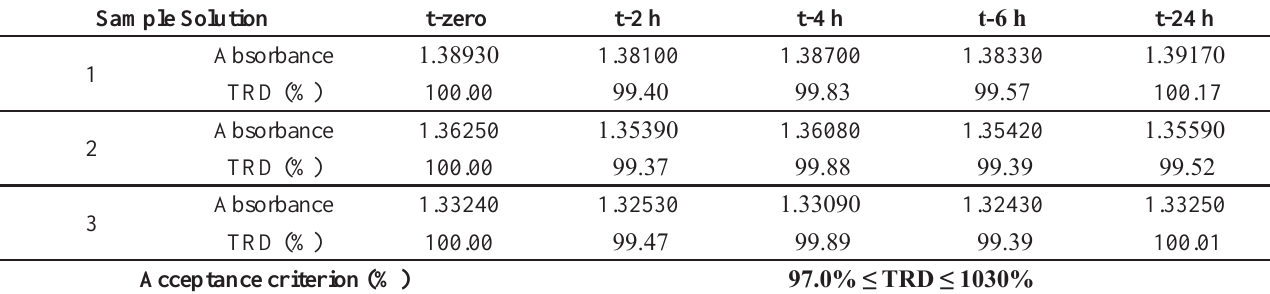
TABLE XI - Results of the stability of the sample solutions ( l = 480